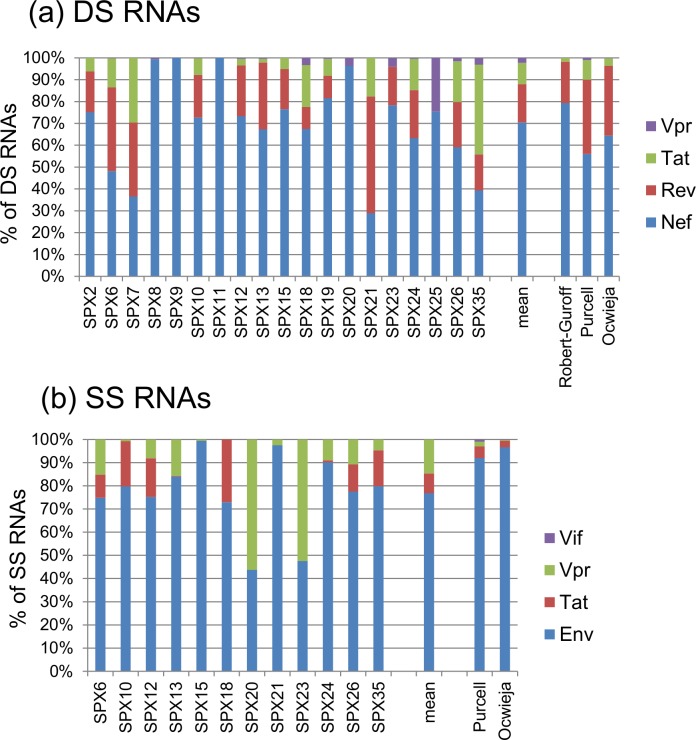
Relative abundance of RNAs coding for different proteins among (a) DS and (b) SS HIV-1 RNAs. The vertical axis represents proportions relative to all transcripts of each category. Mean proportions of all samples are shown on the right of the columns for individual samples. For comparison, proportions reported in in vitro studies by Robert-Guroff et al. [2], Purcell and Martin [6], and Ocwieja et al. [9] are shown.